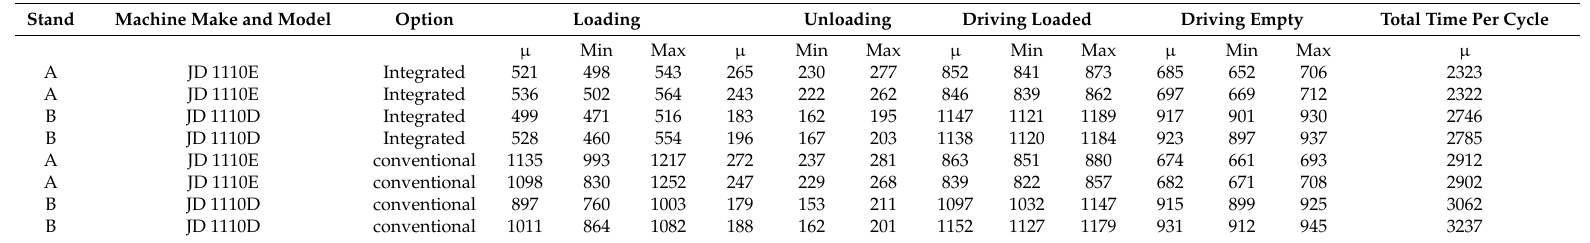
Table 3. Time consumption associated with forwarding operation.